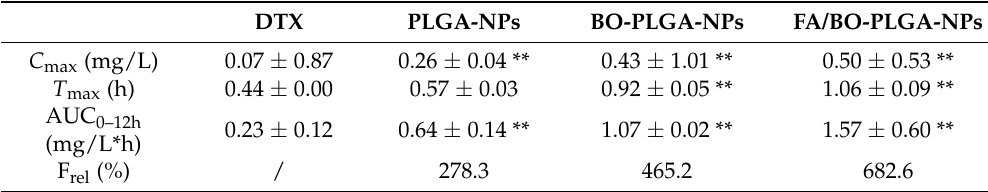
Figure 10. The plasma concentration–time profiles of DTX in SD rats ( n = 6) after the oral administration of DTX suspension, PLGA-NPs, BO-PLGA-NPs and FA/BO-PLGA-NPs with the dose of 10 mg of DTX/kg to rats, respectively. Table 3. Pharmacokinetic parameters of DTX in SD rats ( n = 6) after oral administration of DTX suspension as a control group, and the other groups were treated with PLGA-NPs, BO-PLGA-NPs and FA/BO-PLGA-NPs with the dose of 10 mg of DTX/kg to rats, respectively. (mean ± SD, n = 6).